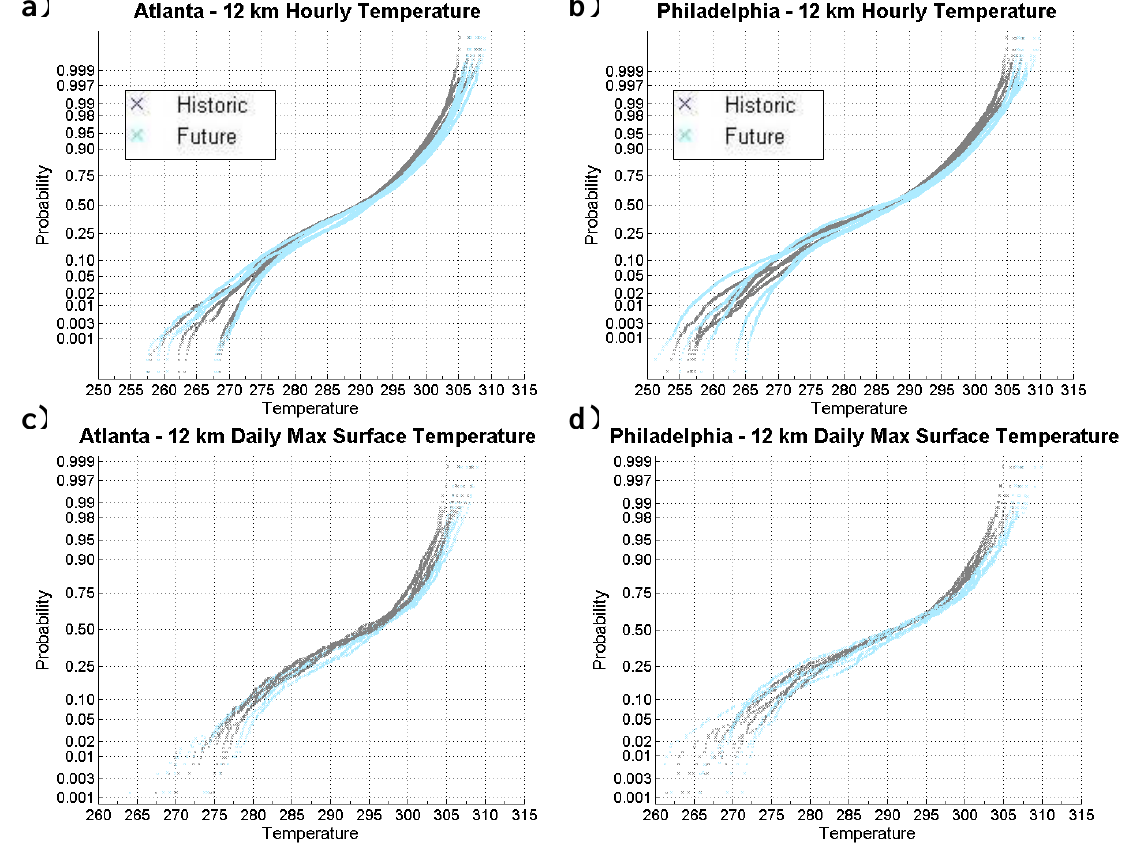
Figure 9: Empirically determined cumulative distribution of 12 km historic (2006-2010) and 646 Fig. 9. Empirically determined cumulative distribution of 12km historic (2006–2010) and future (2048–2050) hourly temperature at (a) Atlanta and (b) Philadelphia, and maximum daily 1h average temperature at (c) Atlanta and (d) future (2048-2050) hourly temperature a) Atlanta, b) Philadelphia and maximum daily 1-hr 647 average temperature at c) Atlanta, d) Philadelphia 648